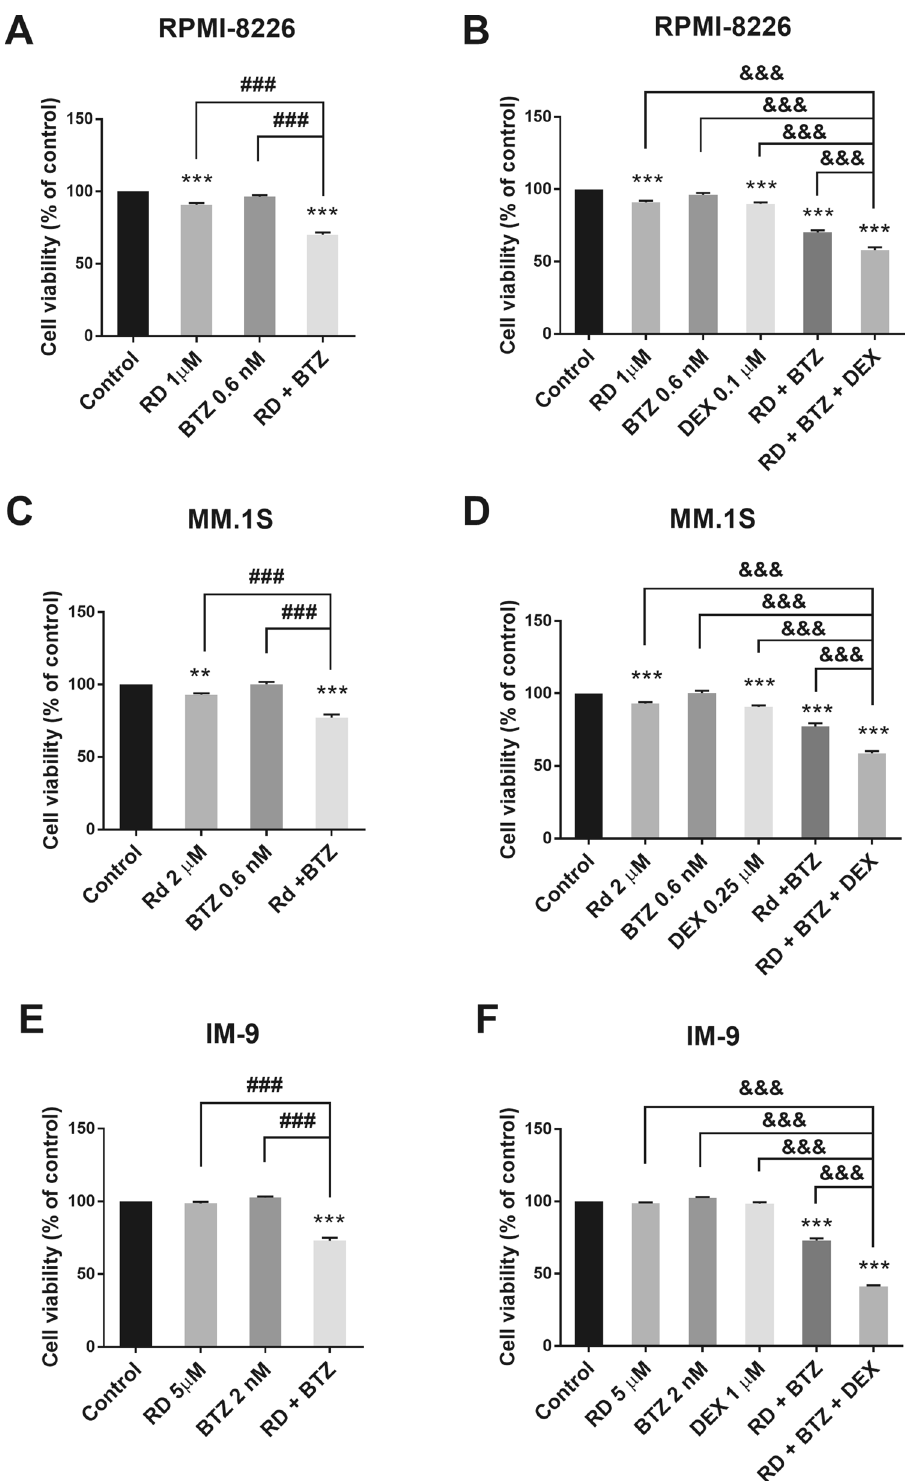
Figure 8. Triple combination effects of radotinib, bortezomib and dexamethasone on cell viability assay in multiple myeloma cell lines, RPMI-8226, MM.1S and IM-9 cells. Cell viability assay was measured by CellTiter 96 solution assay kit (Promega, WI, USA). Combination treatment results for 48 h with radotinib and bortezomib in RPMI-8226 ( A ), MM.1S ( C ) and IM-9 cells ( E ). Triple combination treatment results for 48 h with radotinib, bortezomib and dexamethasone in RPMI-8226 ( B ), MM.1S ( D ) and IM-9 cells ( F ). These data represent the means ± SEM. Significantly different from the control (*), combination (#) and triple combination (&); ***, ### , &&& P < 0.001. RD, radotinib; BTZ, bortezomib, DEX, dexamethasone; RD + BTZ, Combination of radotinib and bortezomib; RD + BTZ + DEX, Triple combination of radotinib, bortezomib and